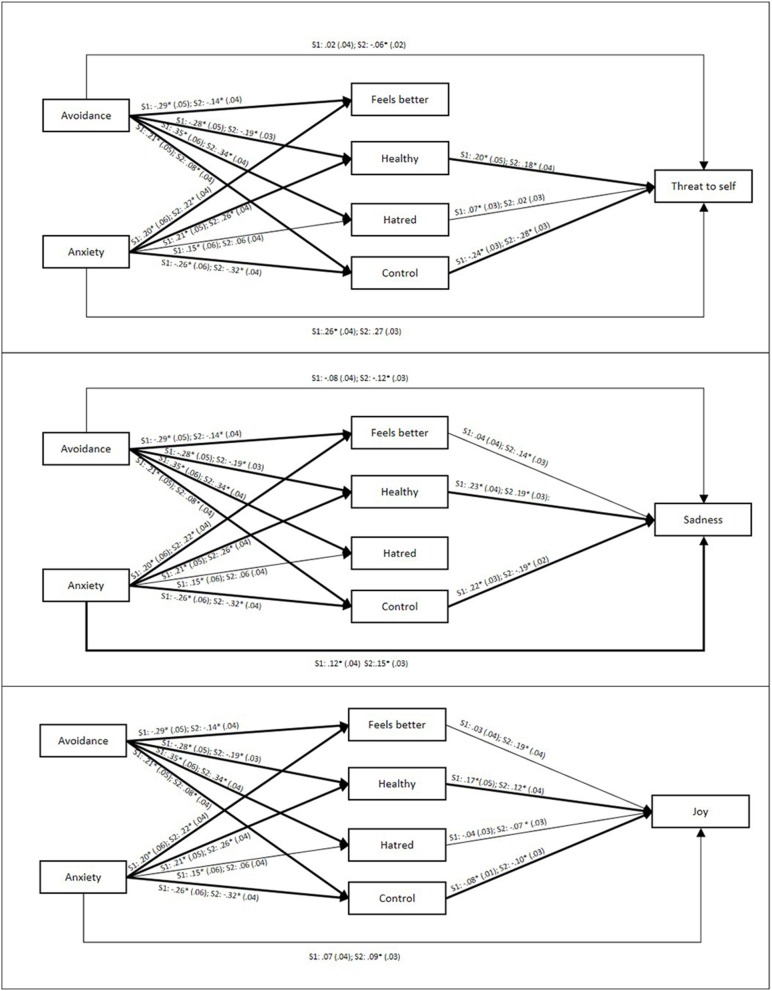
Individual path coefficients for each relationship in the crying proneness mediation models. S1, Sample 1, S2, Sample 2. *p < 0.05. SEs are displayed in parentheses. Paths that were non-significant in both samples are omitted for ease of interpretation. Bold lines indicate that a path was significant in both samples. Coefficients shown control for age, gender, and other coefficients, including omitted non-significant ones.